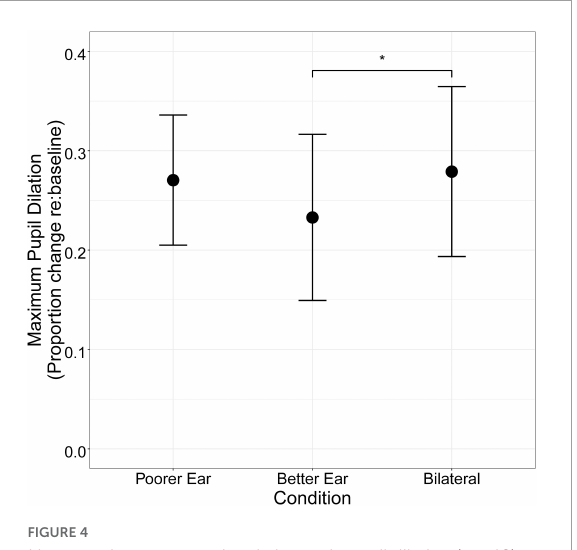
FIGURE4 Mean maximum proportional change in pupil dilation ( n = 12) for each listening condition. Error bars represent ± 1.96 SE (95% confidence interval). Asterisks indicate the significance level of pairwise comparison results (* for p < 0.05, ** for p < 0.01, and *** for p < 0.001).